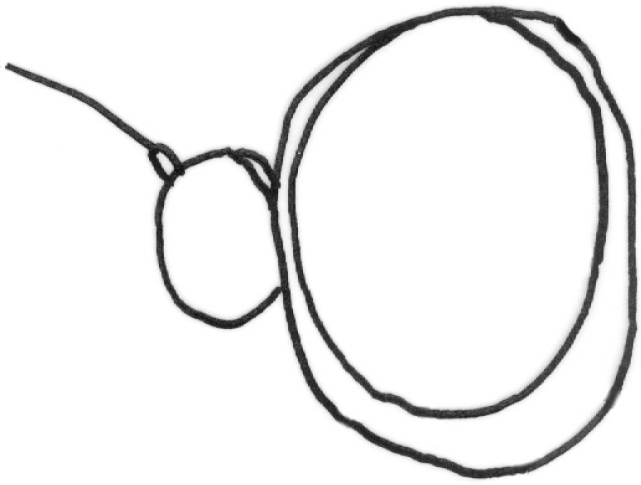
Couplet 2b of key, head, lateral view (after Nartshuk et al. 1970).